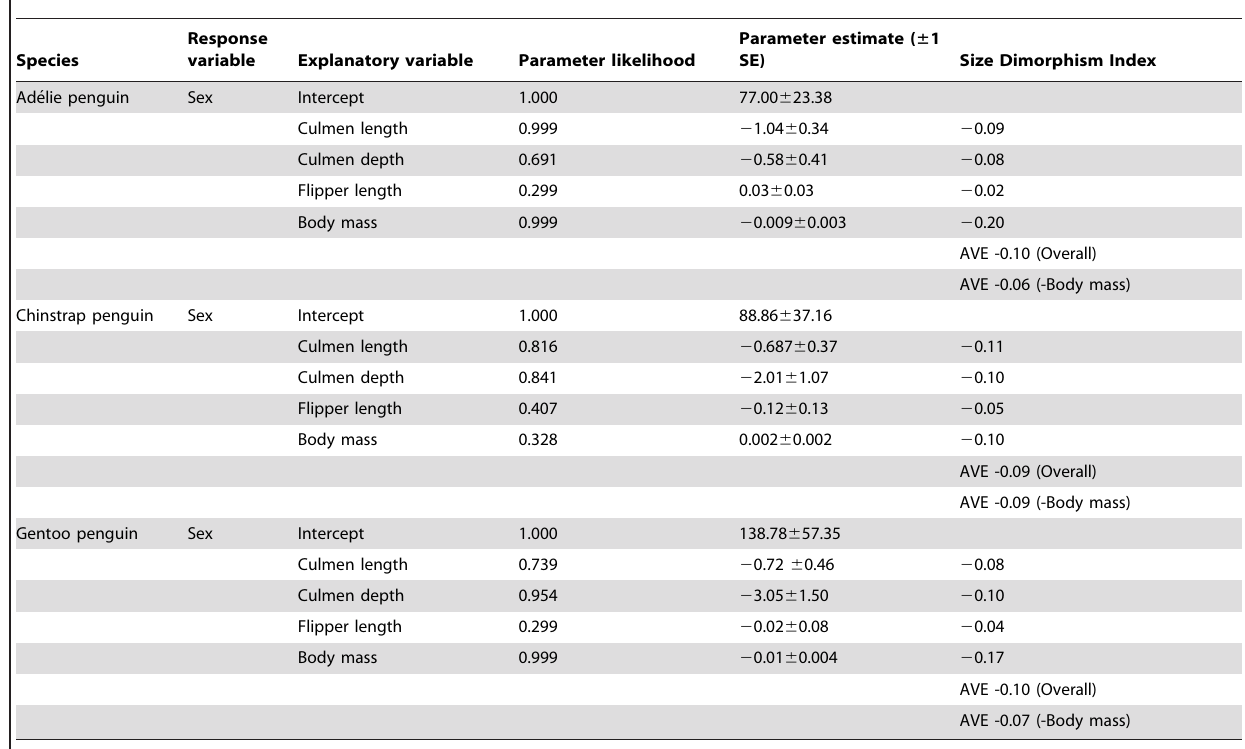
Table 2. Parameter estimates and likelihoods from candidate models for predicting sex of Pygoscelis